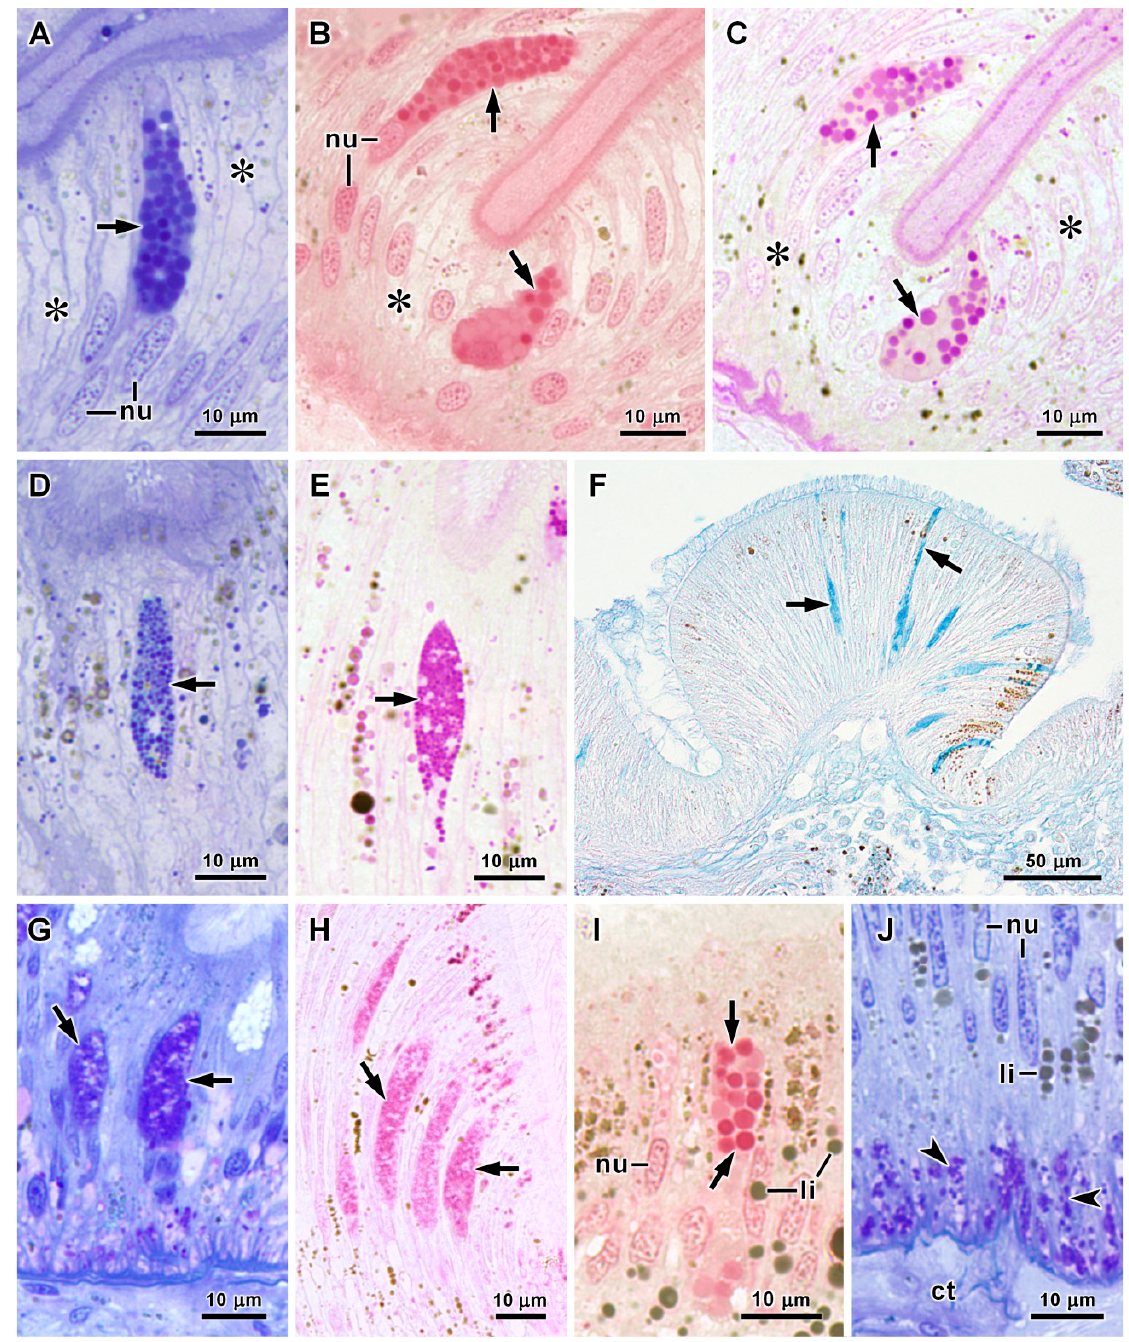
Figure 4. Oesophagus of A. fascicularis ( A – F ) and C. angulata ( G – J ), in semithin ( A – E , G – J ) and histological ( F ) sections. ( A – C ) Absorptive cells (asterisks) and basophilic cells with large secretory vesicles (arrows) in the oesophagus of A. fascicularis stained by methylene blue and azure II ( A ), tetrazonium coupling reaction for protein detection ( B ) and PAS reaction for polysaccharide detection ( C ). ( D – F ). Basophilic cells with small secretory vesicles (arrows) in the oesophagus of A. fascicularis stained by methylene blue and azure II ( D ), PAS reaction ( E ) and Alcian blue for acid polysaccharide detection ( F ). ( G , H ) Mucous cells (arrows) in the oesophagus of C. angulata stained by methylene blue and azure II ( G ) and PAS reaction ( H ). ( I ) Basophilic cell with large secretory vesicles (arrows) in the oesophagus of C. angulata stained by the tetrazonium coupling reaction. ( J ) Basal cells of the oesophagus with purple vesicles (arrowheads) in a section stained with methylene blue and azure II. ct—connective tissue, li—lipid droplets, nu—nuclei.